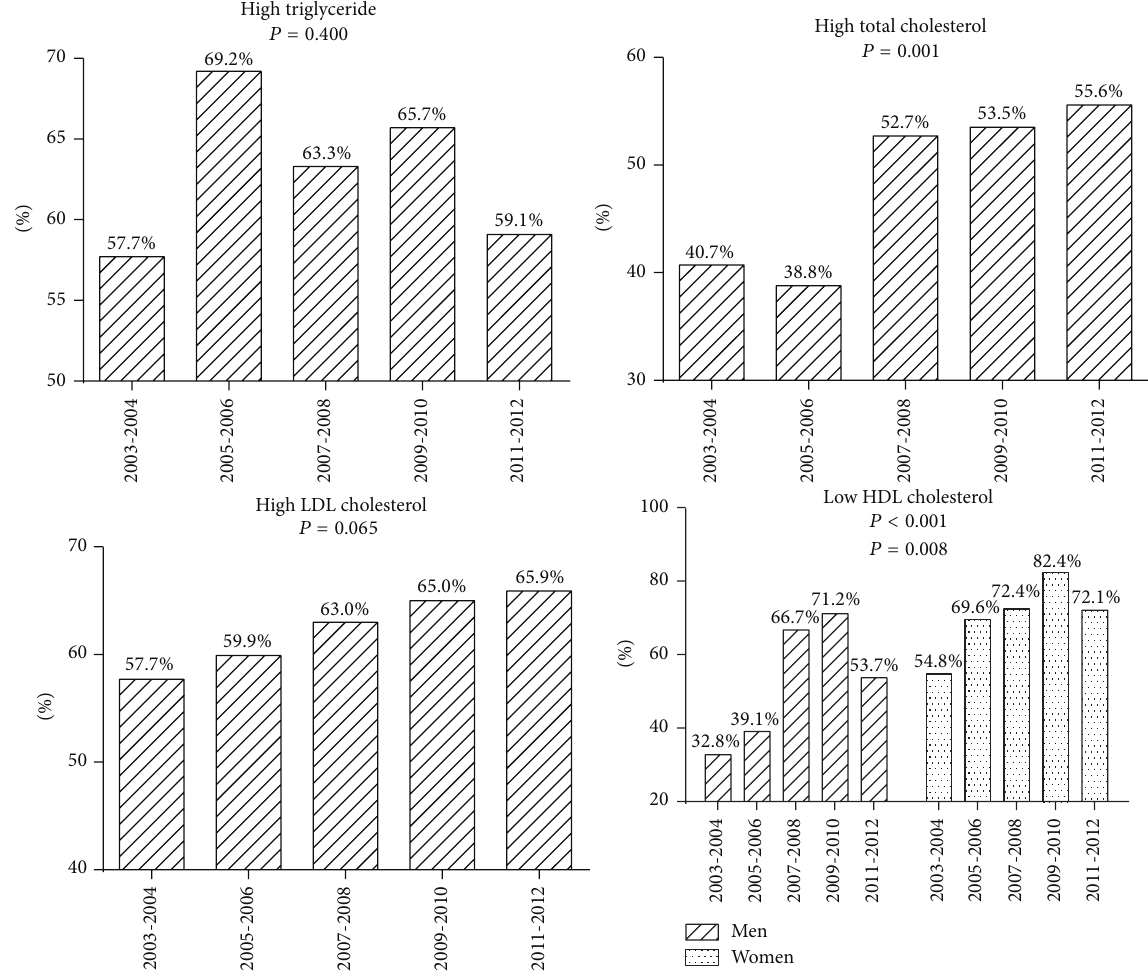
Figure 2: The proportions of patients with dyslipidemia during